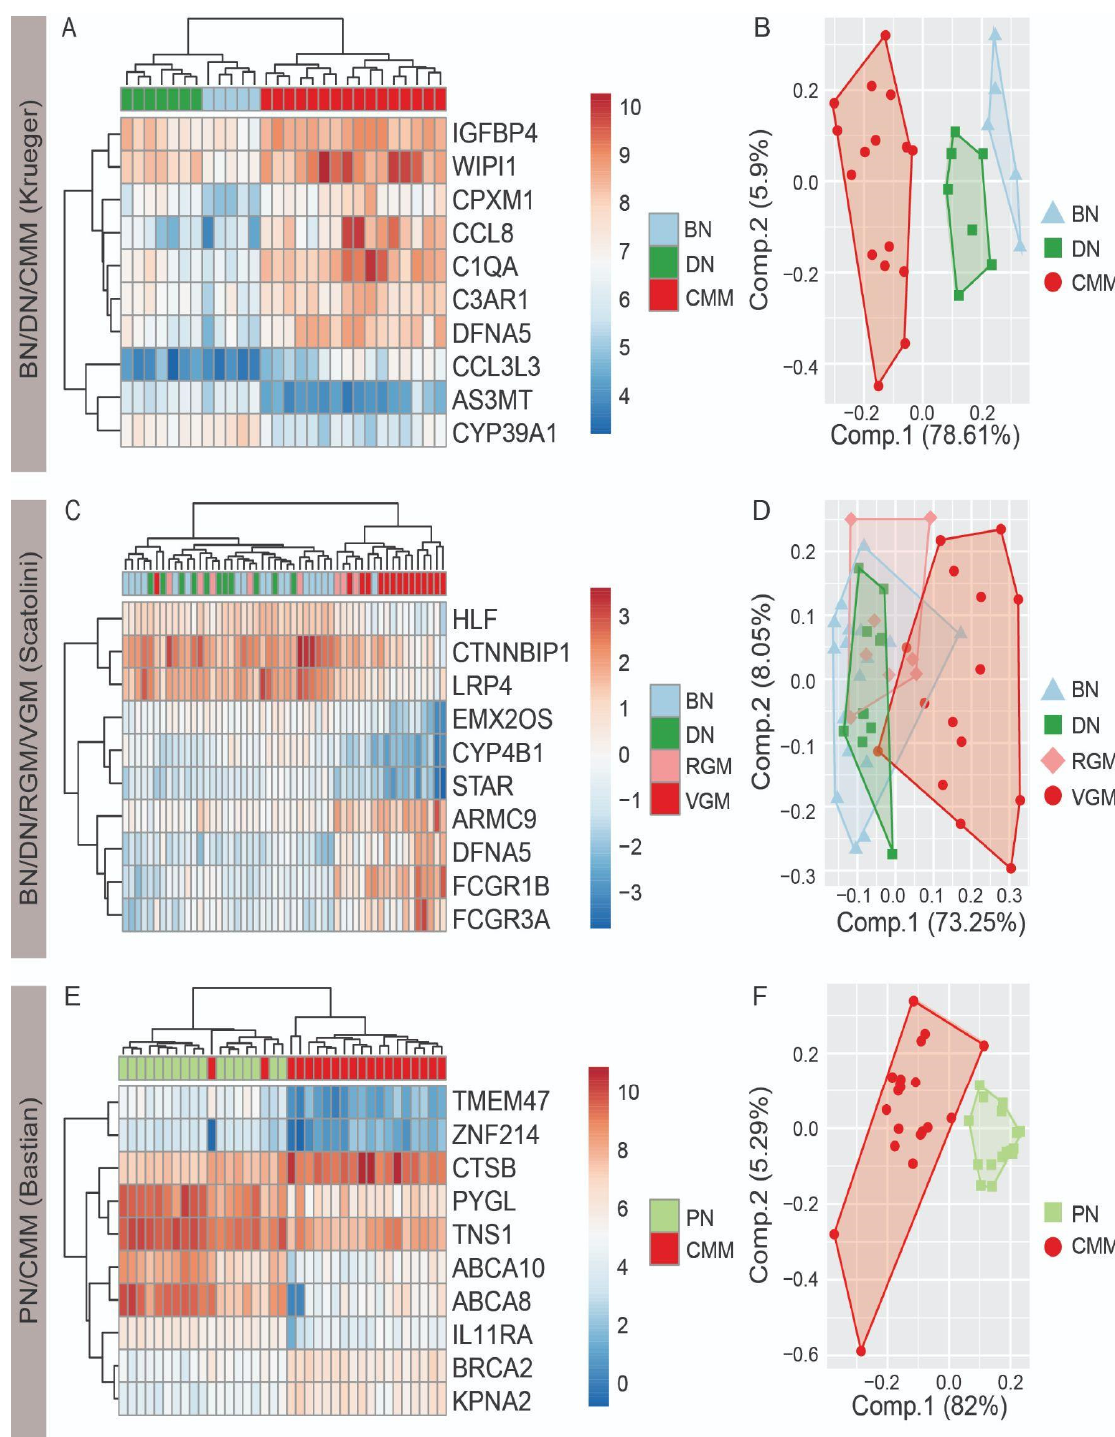
Figure 1. Top ten differentially expressed genes differentiate nevi and melanoma. Differentially expressed genes from each of the pairwise comparisons between the lesions were ranked based on Benjamini–Hochberg-adjusted p -values (absolute log 2 (FC) ≥ 1.5; Benjamini–Hochberg-adjusted p -value < 0.05; False discovery rate = 5%). Hierarchical clustered heatmap and principal components analysis with the top ten differentially expressed genes for ( A , B ) benign nevi (BN), dysplastic nevi (DN), and cutaneous malignant melanoma (CMM) in the Krueger dataset; ( C , D ) BN, DN, radial growth phase melanoma (RGM), and vertical growth phase melanoma (VGM) in the Scatolini dataset; and ( E , F ) progressing nevi (PN) and CMM for the Bastian dataset. FC, fold